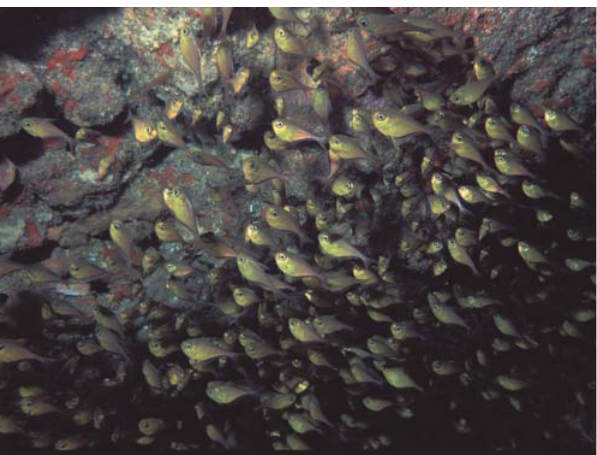
Fig. 2. A large glassy sweeper ( Pempheris schomburgki ) ag- gregation hiding at daytime in a grotto formed by a large boulder.